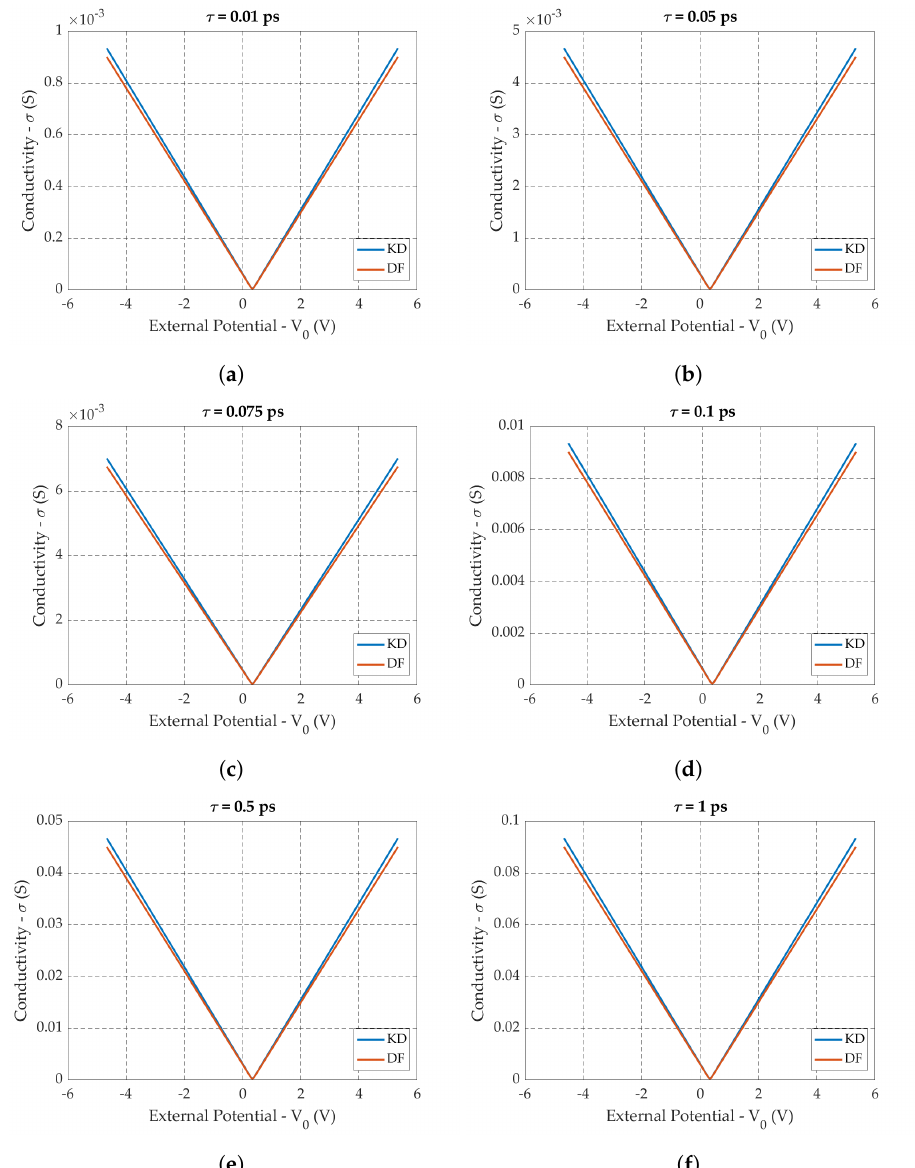
Figure 5. Conductivity of graphene calculated: (i) by the present method (red lines), and (ii) by the Kubo–Drude formulation (blue lines), for different values of the scattering time τ (s), being µ 0 = 2 E F = 0.34 eV and for V 0 ∈ [ − 3,3 ]